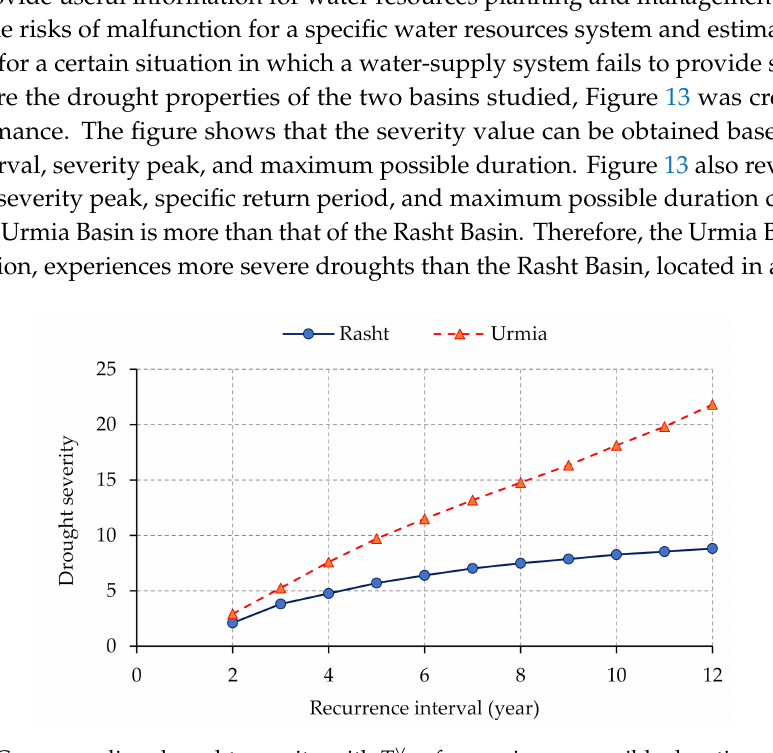
for maximum possible duration and severity DSP